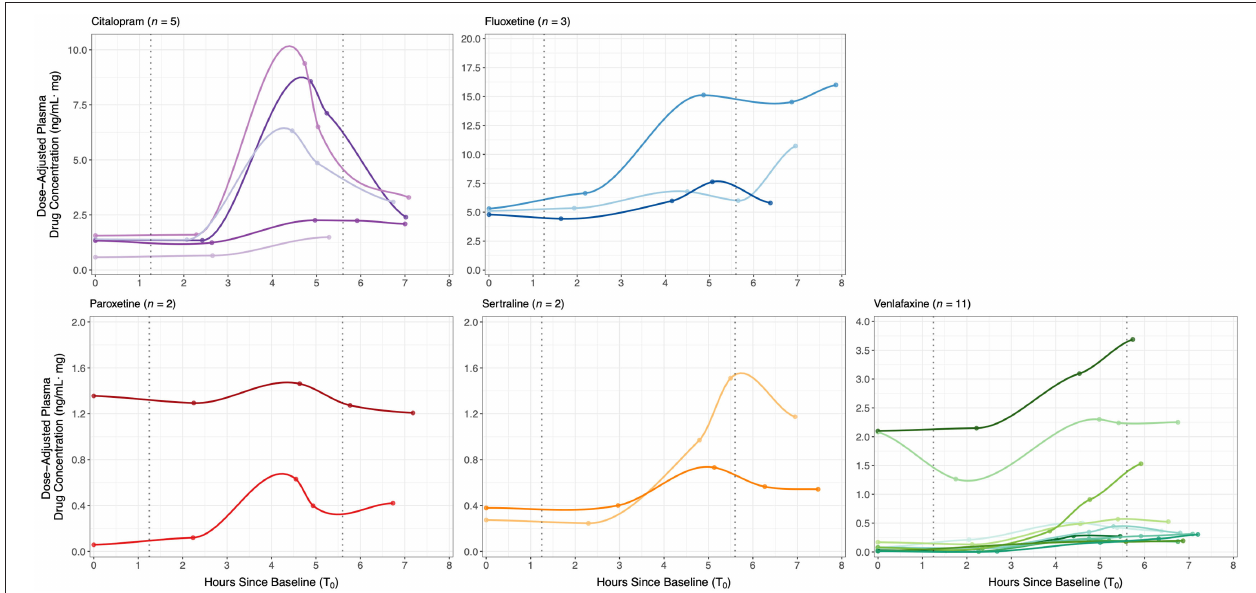
FIGURE 2 | Dose-adjusted plasma drug concentrations (ng/ml · mg) at baseline (T 0 ) and four time-points post-dose across the study protocol for 23 SRI-treated mothers, grouped by antidepressant type. Concentration-time curves demonstrate inter-individual variability in SRI pharmacokinetics and maternal drug levels relative to the start of each fetal assessment; curves were fit to each individual’s data with local polynomial regression. SRI oral dosing occurred a median of 1.83h after T 0 . Median blood collection times were: baseline (T 0 ) at 08h06, post-dose 1 (T 1 ) at 10h21, post-dose 2 (T 2 ) at 12h50, post-dose 3 (T 3 ) at 13h38, and post-dose 4 (T 4 ) at 14h57. Median start times of the baseline/pre-dose and post-dose fetal assessments were at a 1.3 and 5.6h after T 0 , respectively (dotted vertical lines). TABLE 3 | Maternal pharmacokinetic variables (mean ± SE) for each antidepressant type on a subset of SRI-treated women ( n = 23). Antidepressant N AUC last C max T peak 1 T3-T0 (ng/ml) (h) (ng/ml · mg) Citalopram 5 906 ± 271 274 ± 92 4.9 ± 0.14 3.2 ± 1.0 Fluoxetine † 3 3221 ± 1919 613 ± 342 5.8 ± 1.0 4.3 ± 2.5 Paroxetine 2 125 ± 66 24 ± 5.2 4.6 ± 0.04 0.13 ± 0.21 Sertraline 2 728 ± 256 197 ± 105 5.3 ± 0.18 0.71 ± 0.53 Venlafaxine 11 621 ± 314 163 ± 74 5.7 ± 0.30 0.43 ± 0.13 AUC last , area under the curve from T 0 (baseline) to the last measured plasma drug concentration (T 4 ); C max , maximum (peak) plasma drug concentration (ng/ml); T peak , time (hours) from baseline to reach C max ; 1 T3-T0, change in dose-adjusted plasma concentration (ng/ml · mg) from baseline (T 0 ) to post-dose 3 (T 3 ), representing the change in maternal drug concentration between baseline/pre-dose and post-dose fetal assessments. † Fluoxetine not yet reached maximum plasma concentration at time of last blood collection (i.e., T 4 estimated as T peak ). AUC last and C max for fluoxetine may be underestimations.